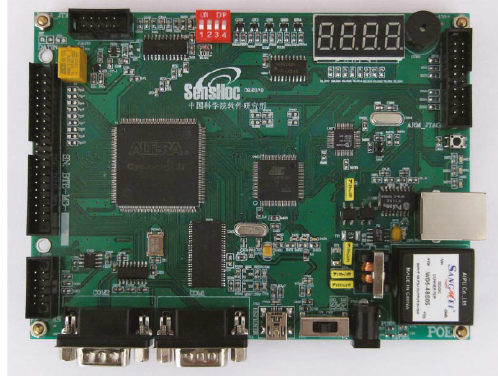
Figure 12: Actual picture of test board.